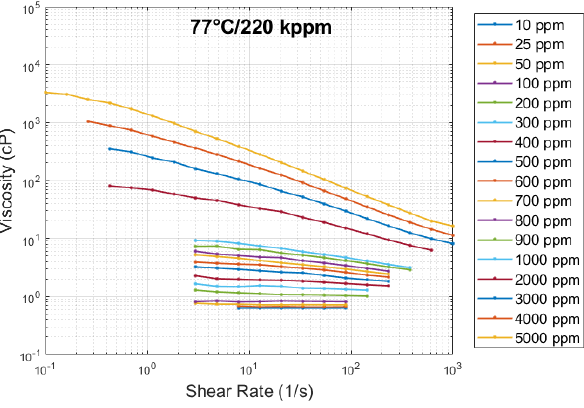
Figure 11: Flow curves graph at 77 ∘ C and 220,000 ppm of NaCl